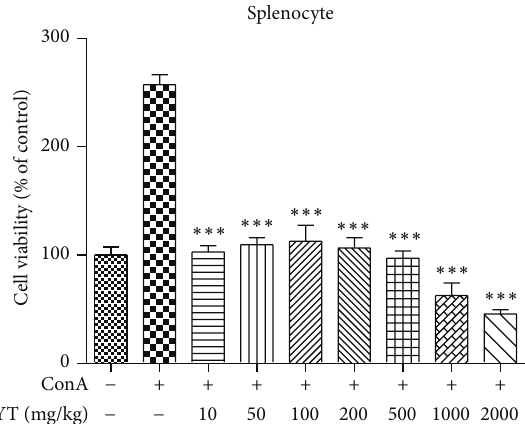
Figure 8: Effect of HYT on splenocyte viability. Splenocytes were treated with various concentrations of HYT (10, 50, 100, 200, 500, 1000, and 2000 ug/mL). Cell viability was measured by WST assay. Thecolumnsandtheerrorbarsrepresentmean ± standarddeviation (SD). ∗ 𝑃 < 0.05 , ∗∗ 𝑃 < 0.01 , and ∗∗∗ 𝑃 < 0.001